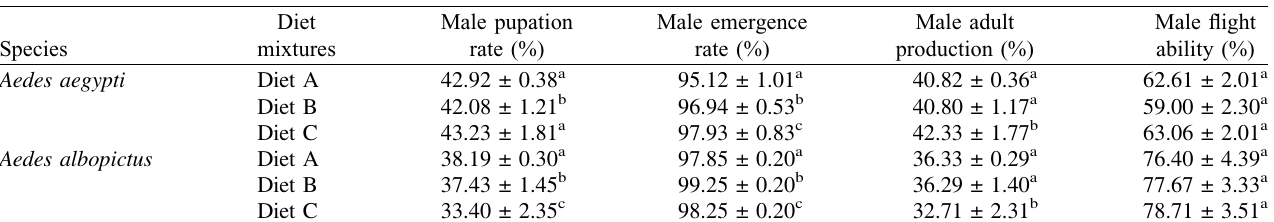
Table 2. Male pupation, emergence and adult production percentages, and fl ight ability of Aedes aegypti and Aedes albopictus reared with different larval